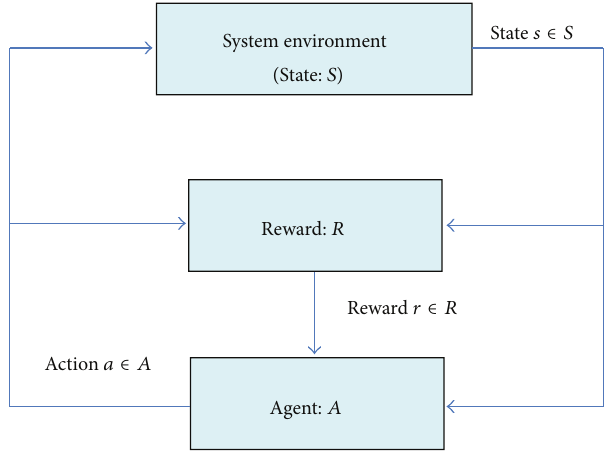
Figure 1: Reinforcement learning